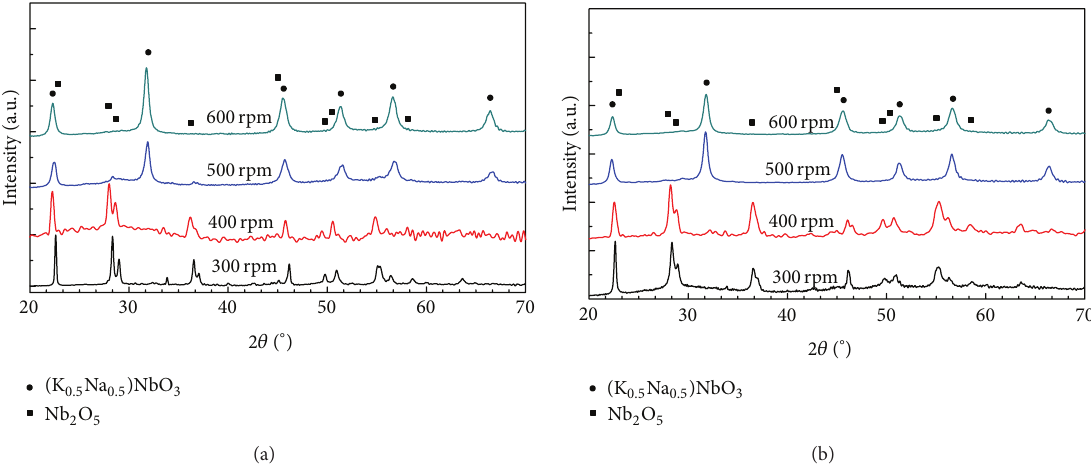
Figure 4: X-ray diffraction diagrams of as-milled (K 0.5 Na 0.5 )NbO 3 prepared mechanochemically for (a) 5 h and (b) 10h with the ball-to- powder mass ratio of 35/1 at 300, 400, 500, and